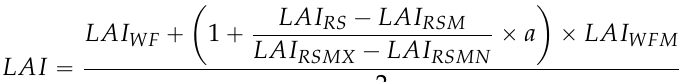
Figure 5. Reasons for selecting the new assimilation method.